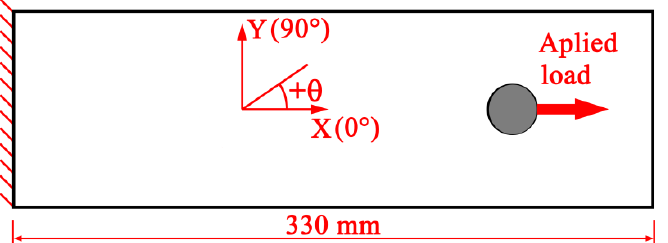
Figure 13. Schematic of the simplified calculation model with fibre orientation coordinates, load conditions and boundary